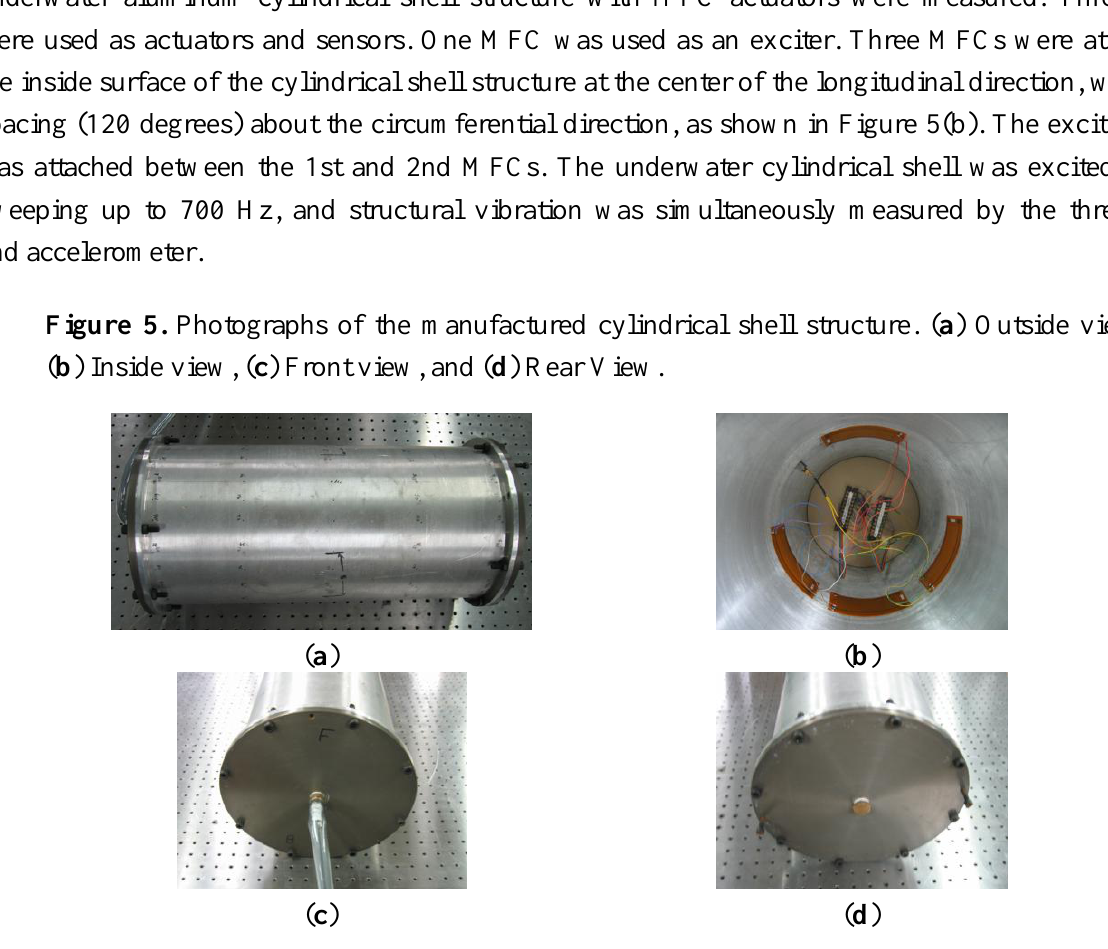
Figure 6. Experimental apparatus for the modal test of the underwater cylindrical shell